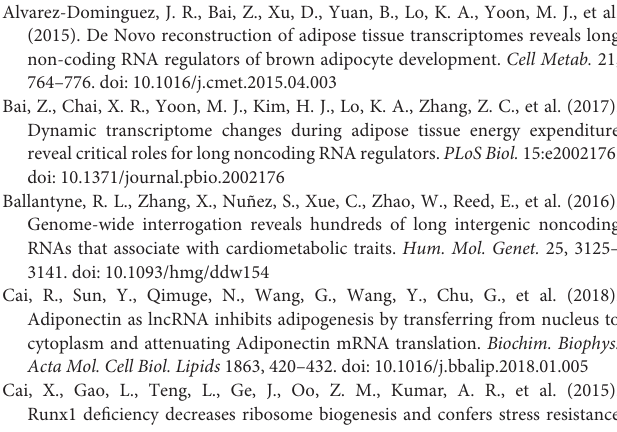
Supplementary Figure 1 | Verification of differentially expressed LncRNAs by qRT-PCR. Twelve differential expressed LncRNAs selected by co-expression and Venn analysis were further verified by qRT-PCR in control group, fasted for 72 h (72 h) group, and refeeding for 48 h (48 h) group. All data are expressed as the mean ± SEM, N.S denotes not significant, N = 6, *Indicates the difference between the control group and F72h. #Indicates the difference between F72h and